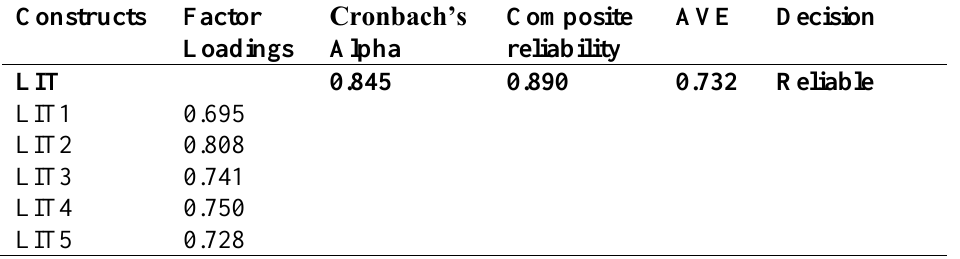
Table 2: Validity and